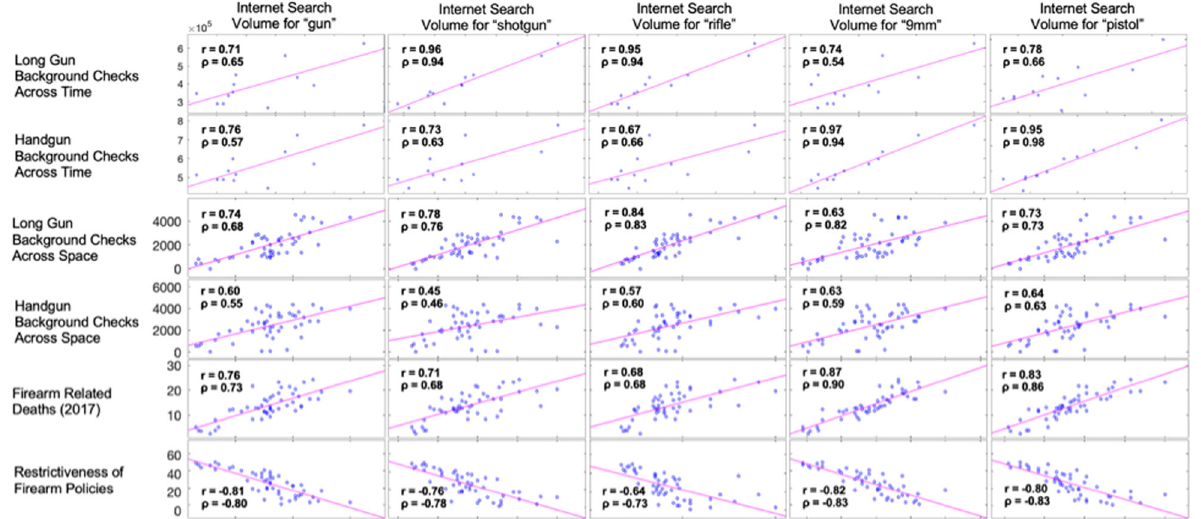
Fig. 8 Analysis and search term correlation plots. Correlation plots and corresponding Pearson ’ s r and Spearman ’ s ρ values for all analyses and all search